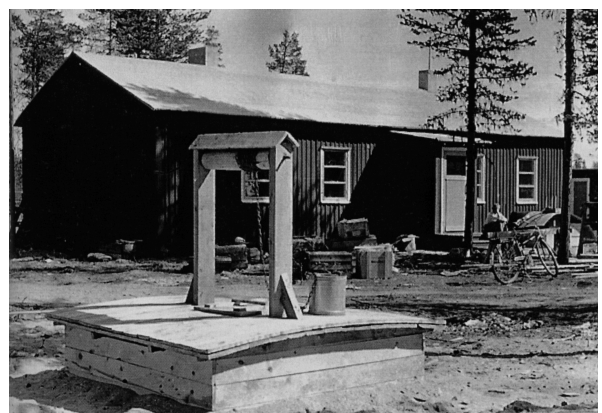
Figure 8. The ionospheric station with a well in the foreground (photo by Juhani